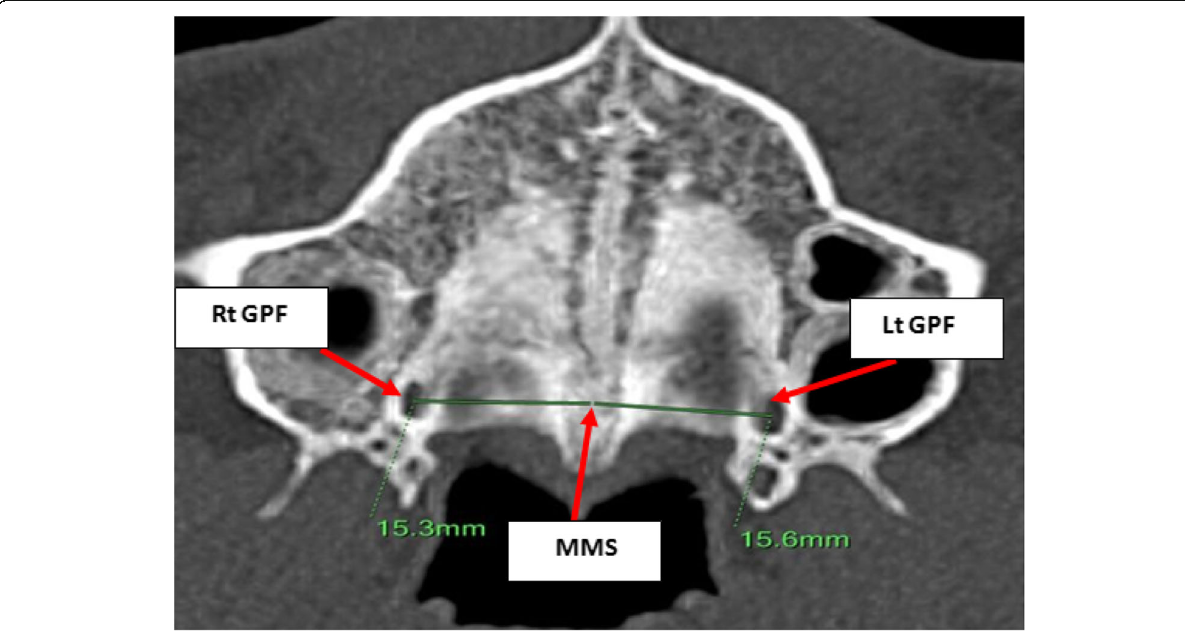
Fig. 10 A CT scan at the region of hard palate illustrating the shortest perpendicular distance from the center of greater palatine foramen (GPF) to midline maxillary suture